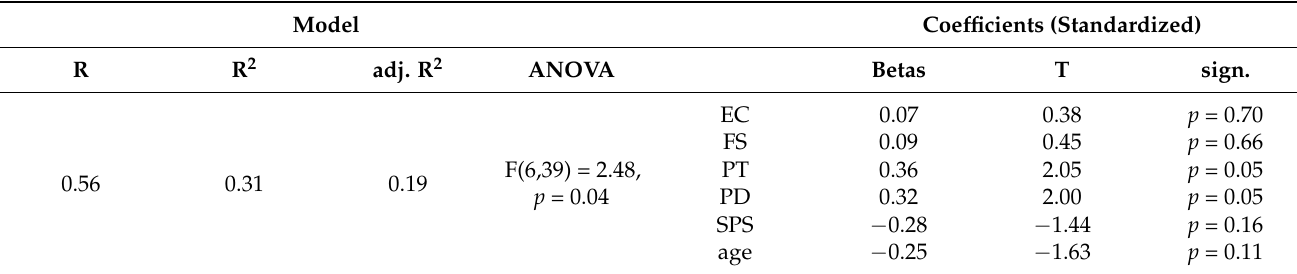
Table 4. Regression analyses of tactile performance of the left hand with personality measures age as